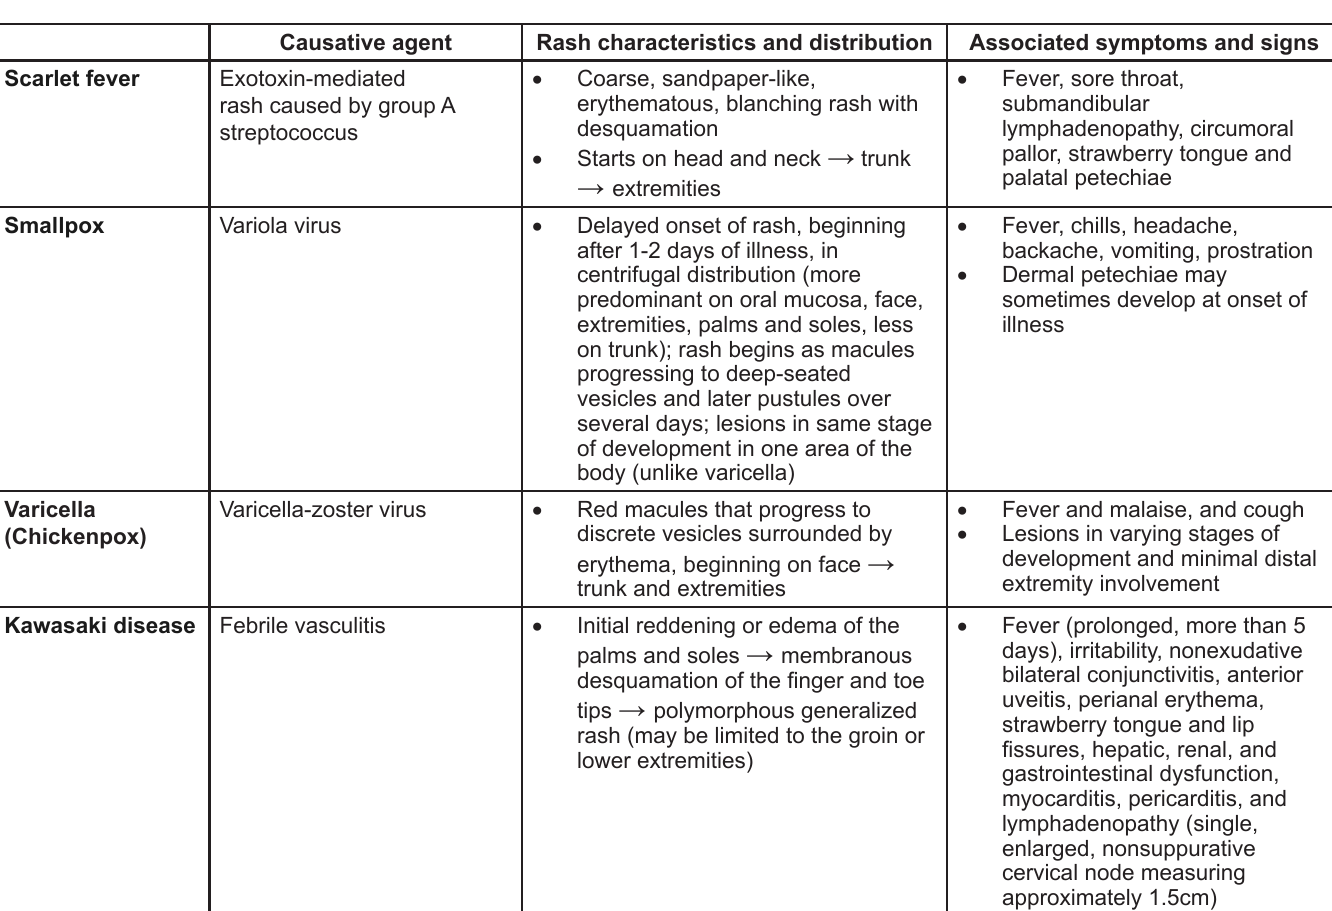
Figure 5 . Pediatric exanthems that may mimic measles,